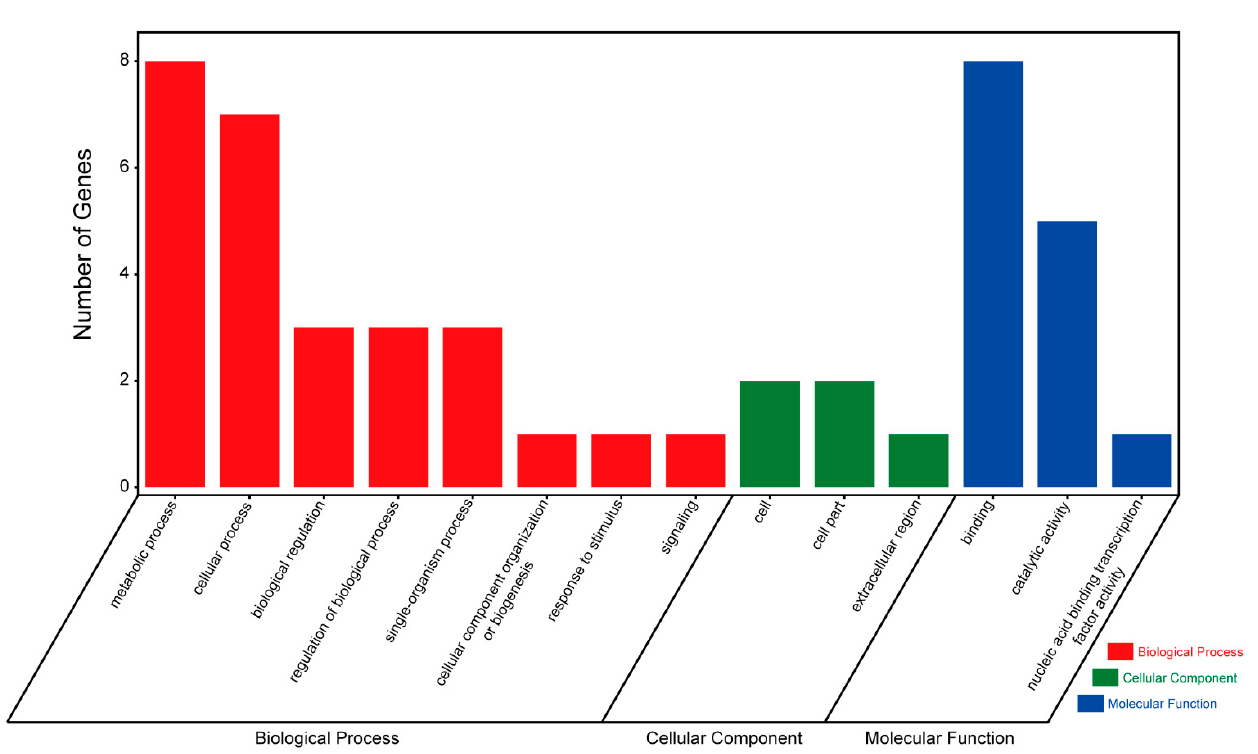
Figure 3. Gene ontology (GO) enrichment analysis of the 37 candidate genes. The red, green, and blue bars represent the biological process, cellular component, and molecular function, respec- tively.